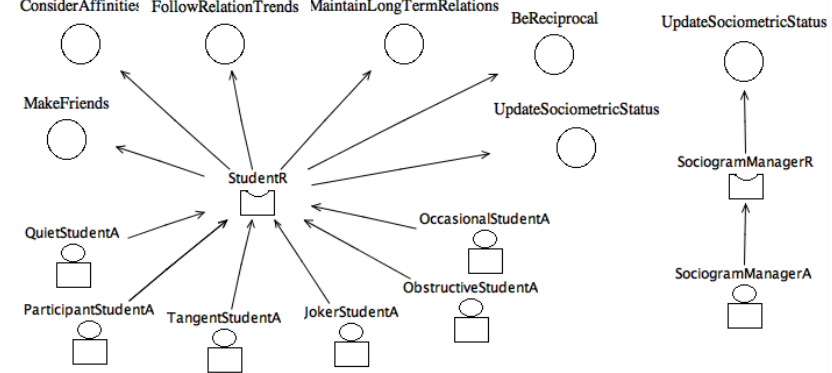
Figure 5. Definition of the roles and agents of